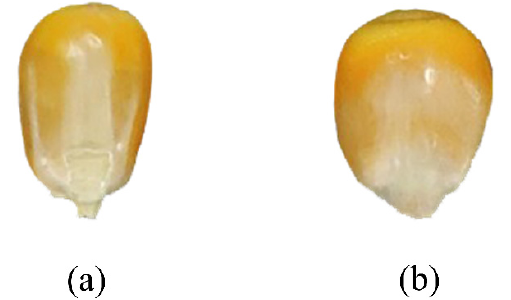
Figure 1. ( a ) Embryo side; ( b ) endosperm side.